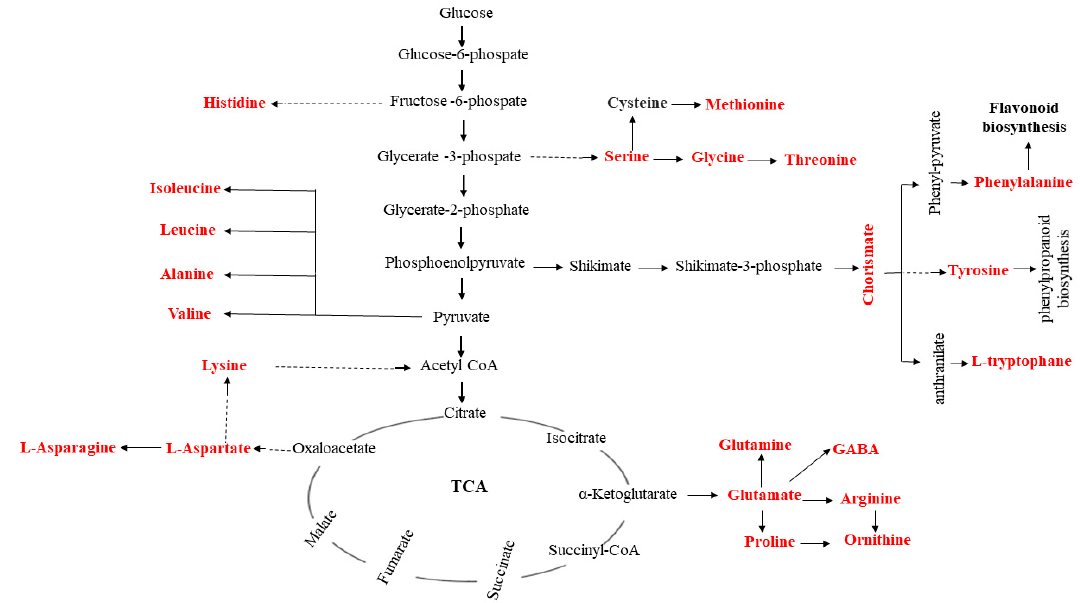
Figure 3. Changes in amino acid levels in the context of amino acid biosynthesis pathways in date palm leaves under UV-B irradiation. Metabolites detected shown in red color, solid lines represent one-step reactions, and dashed lines represent multi ‐ step reactions.